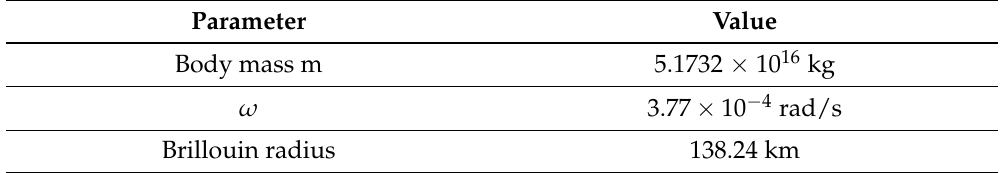
Table 1. Asteroid 216 Kleopatra